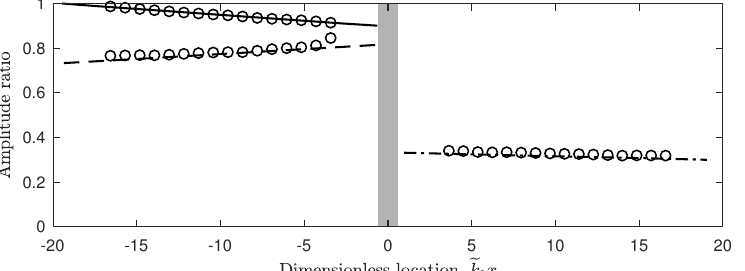
Figure 4. Variation of wave amplitude before and after the surface obstacle (denoted by the shaded box). Lines: model predictions (solid: incident wave component; dashed: reflected wave; dashed- dotted: transmitted wave). Symbols: corresponding numerical results [26]. Distance is normalized by the typical wavelength of the incident wave, 1/ (cid:101) k 0 . Wave amplitude is normalized by the incident component at (cid:101) k 0 x ≈ 20. In this example, ρ w / ρ m = 0.9, ν m = 0.003 m 2 /s, d = δ m , B = W = 0.4 m, h = 0.8 m, and (cid:101) k 0 = 1.5 m − 1 .